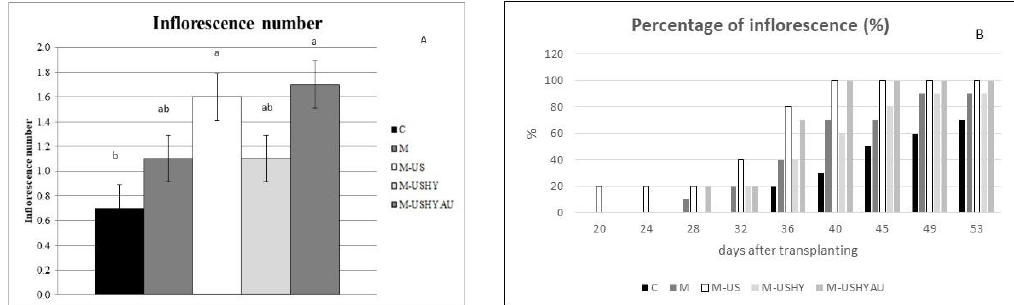
Figure 3. Inflorescence number per plant ( A ) and percentage of inflorescence ( B ). Data are means ± standard error. Values followed by different letters are significantly different ( p < 0.05). The values are the means of data from 12 plants for each